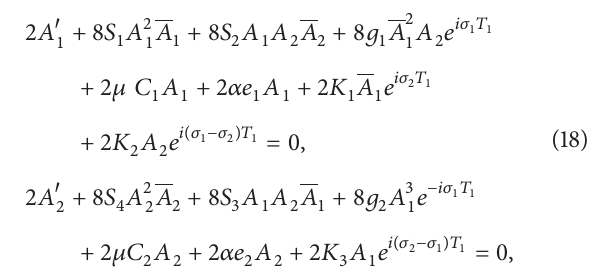
parametric resonance of the difference type, is also activated simultaneously. Substituting (15) and (16) into (10), we